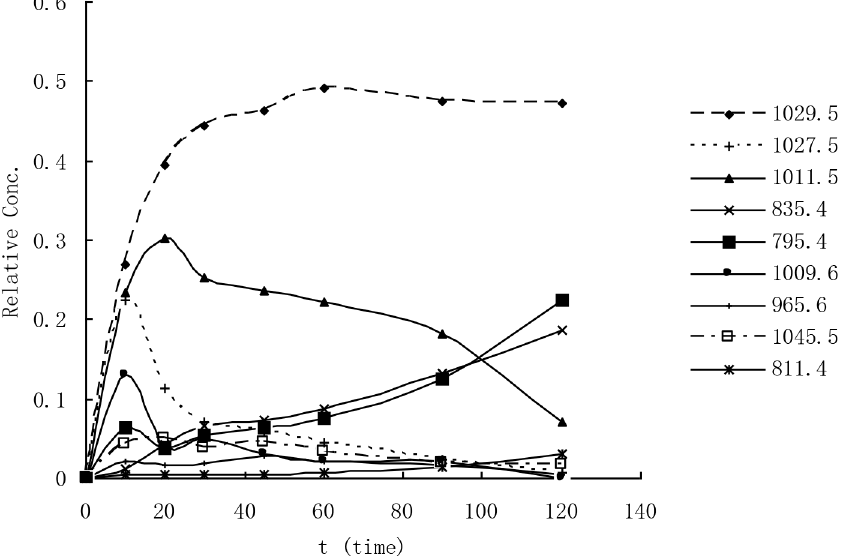
Fig 5. Relative yield of product ions versus time in the UV/H2O2 treatment.